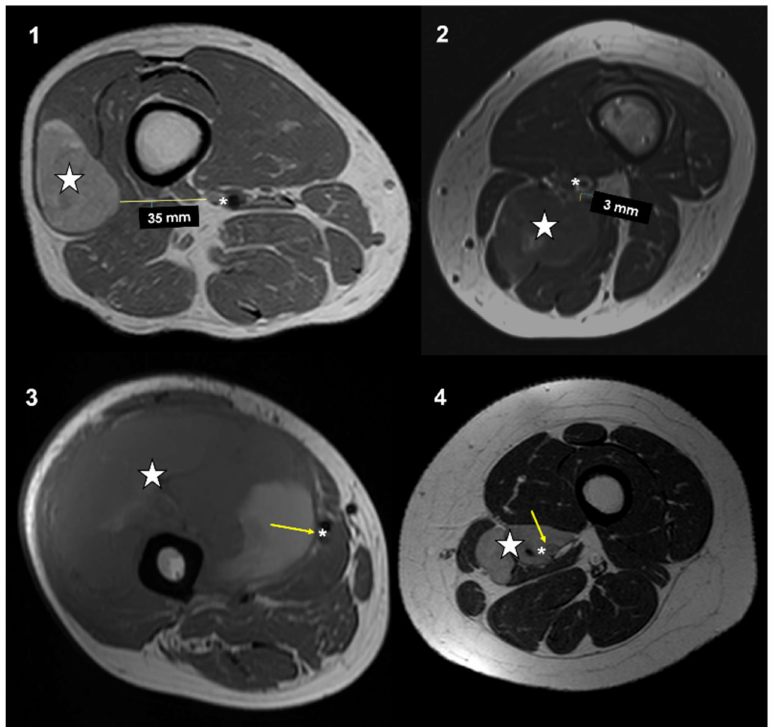
Figure 1. Types of vascular proximity based on MRI T1w axial images performed in four different patients affected by soft-tissue sarcomas of the thigh and popliteal fossa: type 1: >5 mm; type 2: >0 mm and <5 mm; type 3: in contact; type 4: surrounded. Stars (neoplasms), asterisks (main vessels), arrows (tumor-vascular